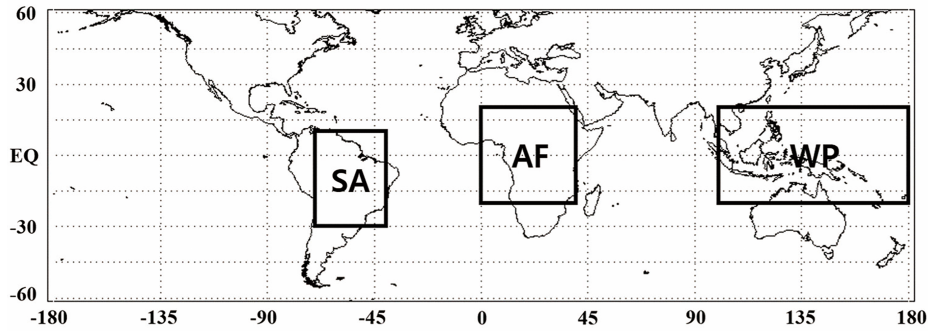
Figure 1. Analysis domains used in this study. SA, AF, and WP represent South American, Central African, and the western Pacific domains, respectively. The western Pacific domain is further divided into its land (WP-land) and ocean area (WP-ocean) in this study.